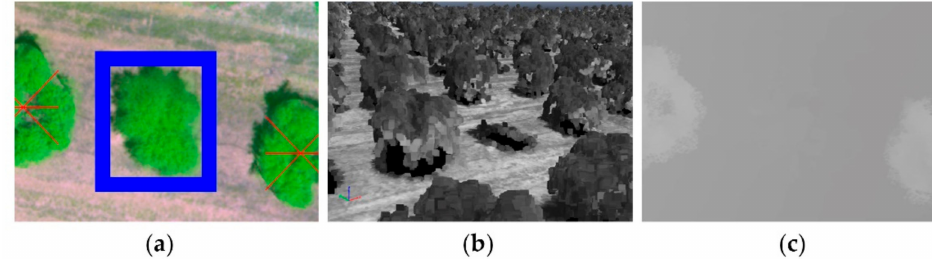
Figure 15. False negative resulting from a lack of information in the point cloud: ( a ) aerial sub-image where the tree wrongly discarded by the algorithm is represented; ( b ) 3D point cloud-based representation of the area shown in ( a ); ( c ) elevation information provided by the DSM, represented as a greyscale image, corresponding to the area shown in ( a